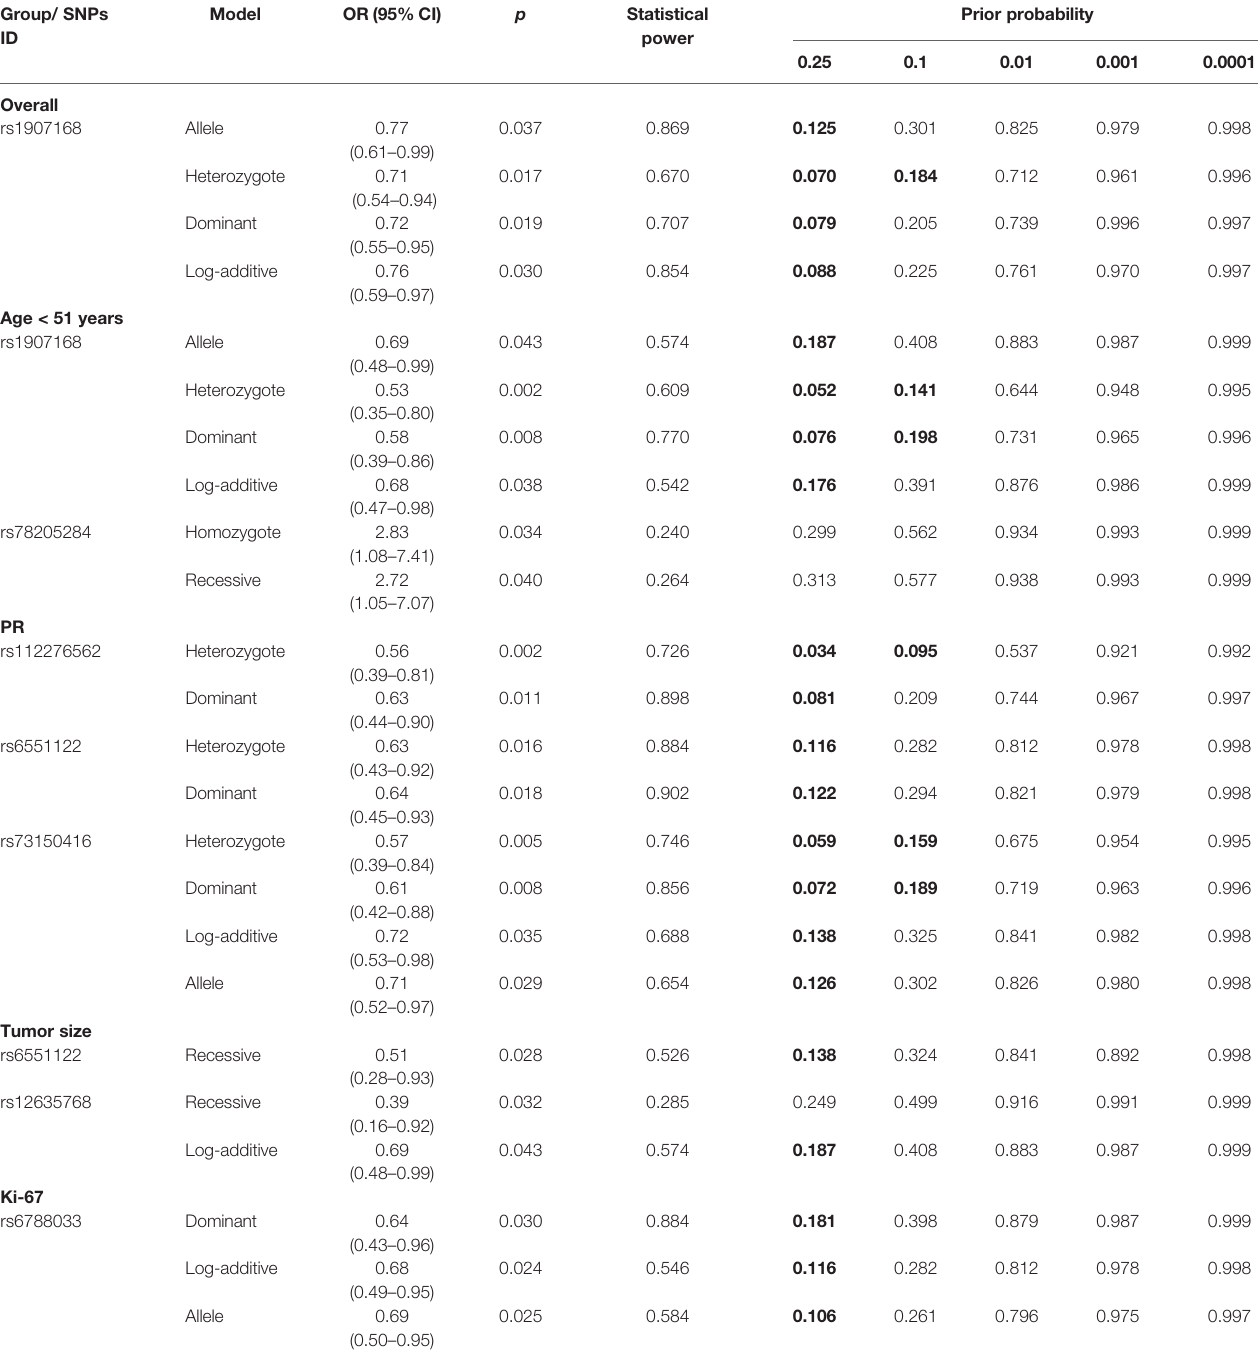
TABLE 5 | False-positive report probability values for the associations between LRRC3B Polymorphisms and BC susceptibility. Group/ SNPs